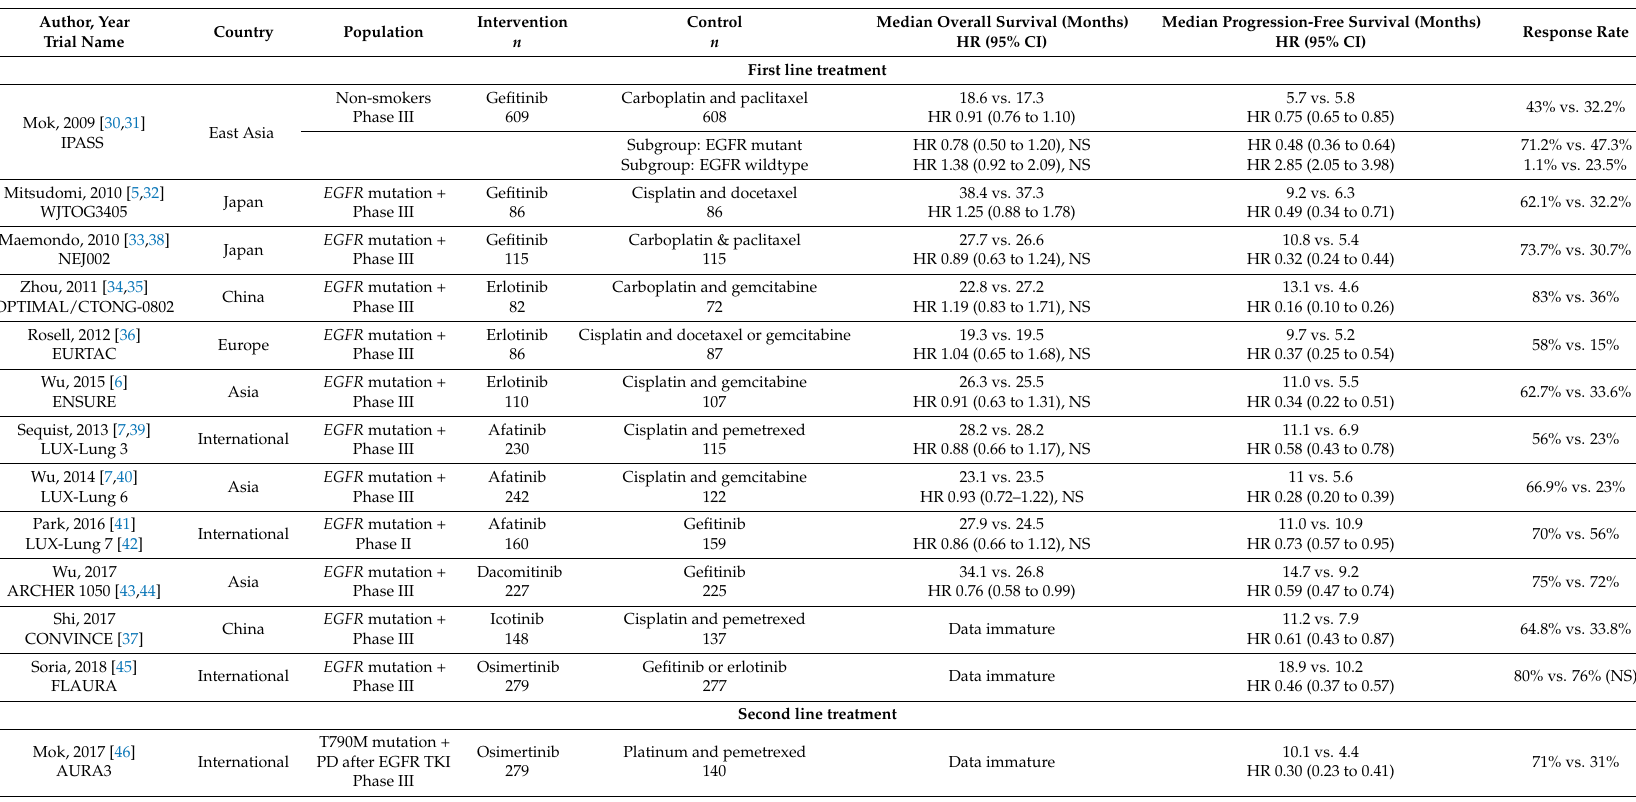
Table 2. Pivotal randomised controlled trials of Epidermal Growth Factor Receptor (EGFR) TKIs in patients with Stage IIIB/IV non-small cell lung